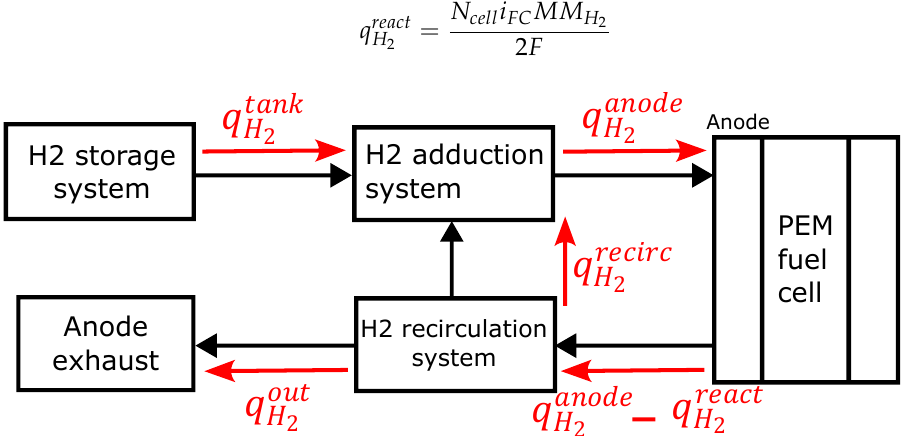
Figure 9. Schematic representation of the hydrogen mass flows in the hydrogen adduction